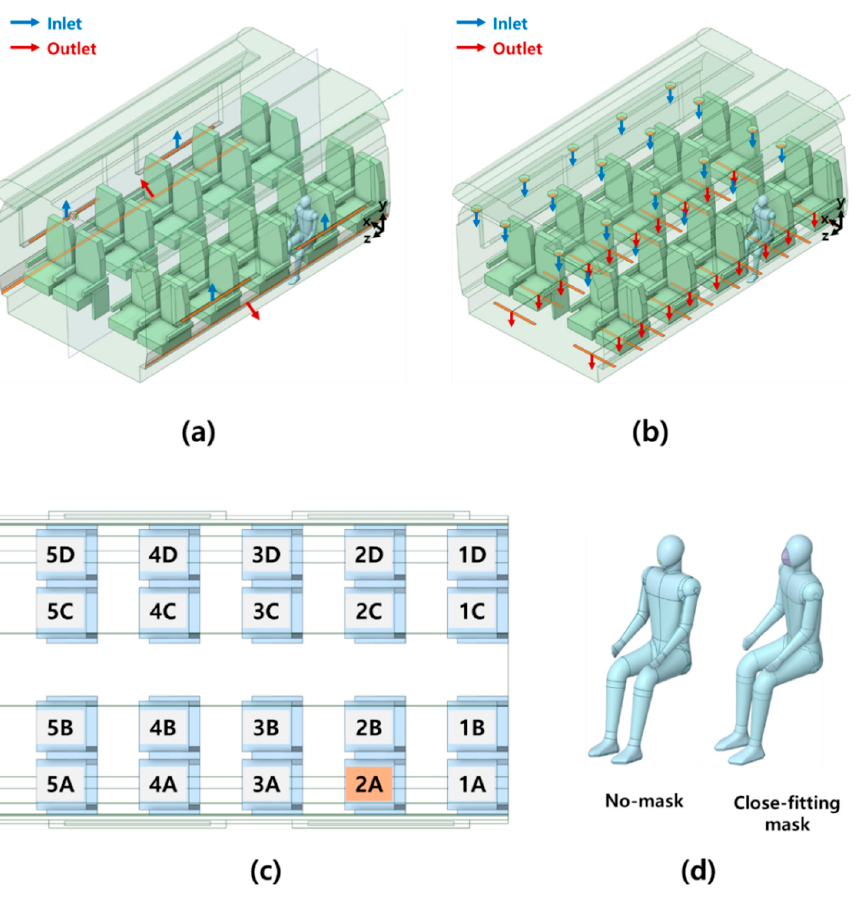
Figure 1. Simulation domain and schematic structure in the high-speed train cabin: ( a ) conventional system; ( b ) vertical drop airflow (VDA) system; ( c ) location of seats; and ( d ) the infected person without a mask and with a close-fitting mask. Table 3. Geometric parameters of the conventional and vertical drop airflow (VDA) Table 2. Specifications of the high-speed train cabin.